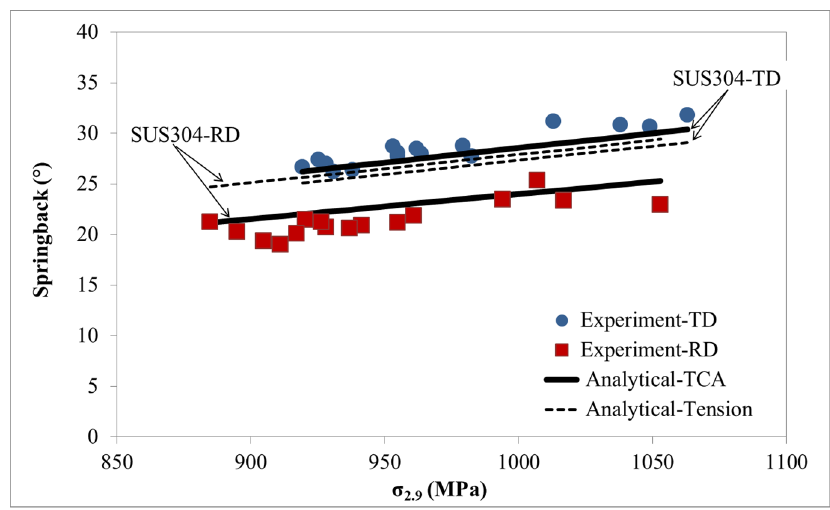
Figure 16. Comparisons of experimental and analytical springback in V-bending for SUS304 with di ff erent material strengths.